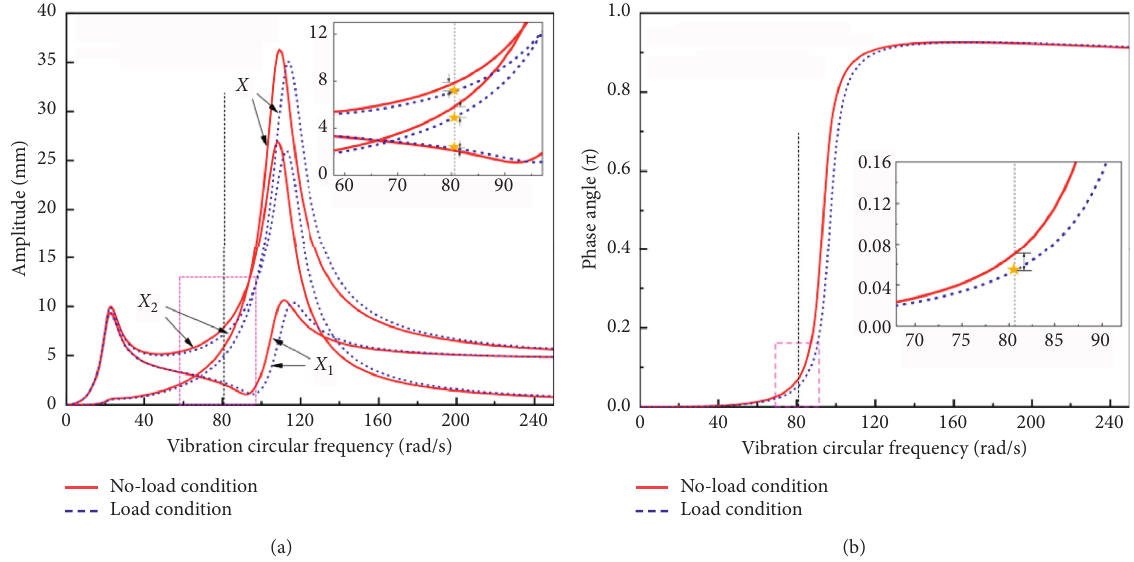
Figure 6: Theoretical dynamic response of VFFS. (a) Amplitude. (b) Phase angle.